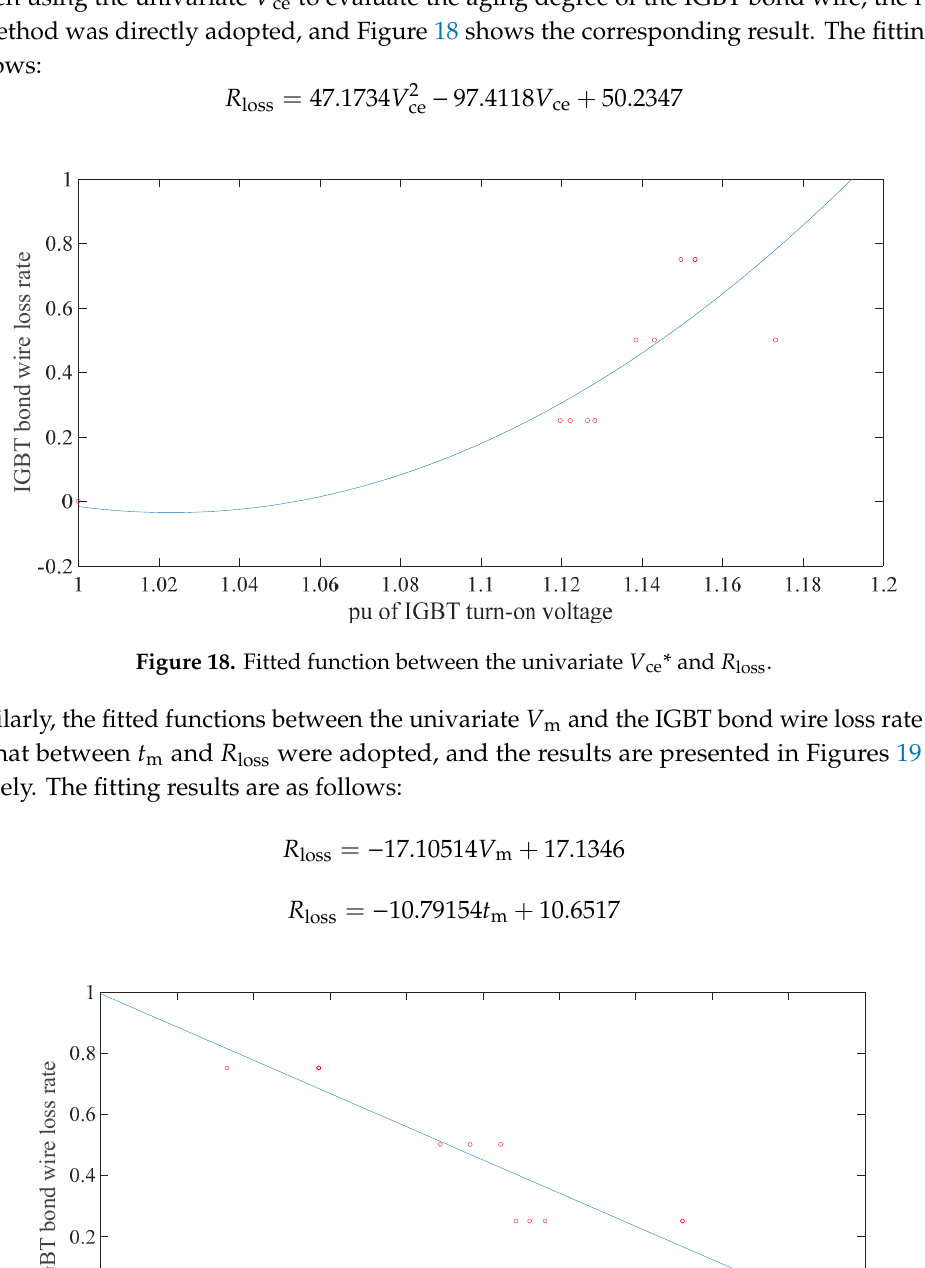
Figure 17. Diagram comparing the monitored and actual values.